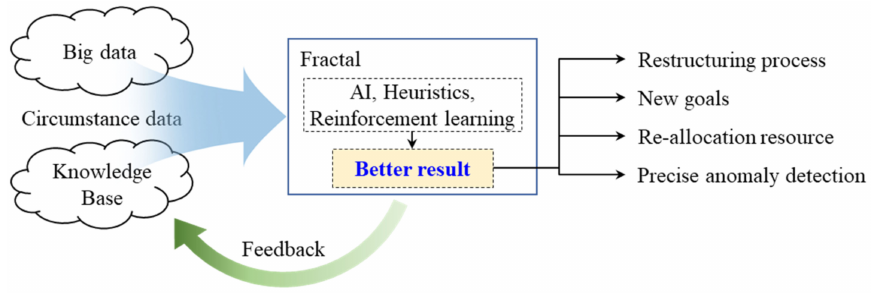
Figure 6. Self-learnable characteristic for